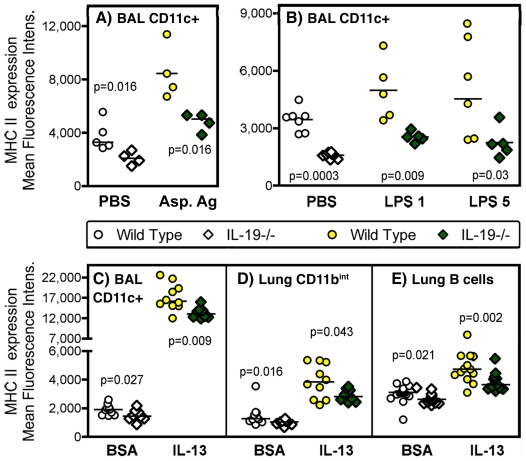
Decreased expression of MHCII in antigen presenting cells from the lungs of IL-19-/- mice.MHCII expression was determined by flow cytometry in CD11c+ cells from the BAL (A-C), in CD11bint cells from the lungs (D), or in B cells (CD19+, B220+) from the lungs (E). The gating strategy is shown in Figure S2. Cells were analyzed from primed animals that were challenged with Aspergillus antigen (A, Asp. Ag, shaded symbols) and from naïve animals that were challenged with LPS (B, at 1 or 5 µg/dose as indicated, shaded symbols) or IL-13 (C-E, shaded symbols). Control animals (open symbols) were given saline (PBS) intranasally or saline containing bovine serum albumin (BSA), the carrier protein used to stabilize IL-13. The experimental schedules are outlined in Figure S1. Wild type and IL-19-/- mice were of the BALB/c (A), or C57BL/6 (B-E) strains. Points represent data for mean fluorescence intensity measured in cells that were harvested from individual wild type (circles), or IL-19-/- (diamonds) mice pooled from 2 experiments each. Horizontal lines indicate medians. Significance levels were calculated with the Mann-Whitney-U test.